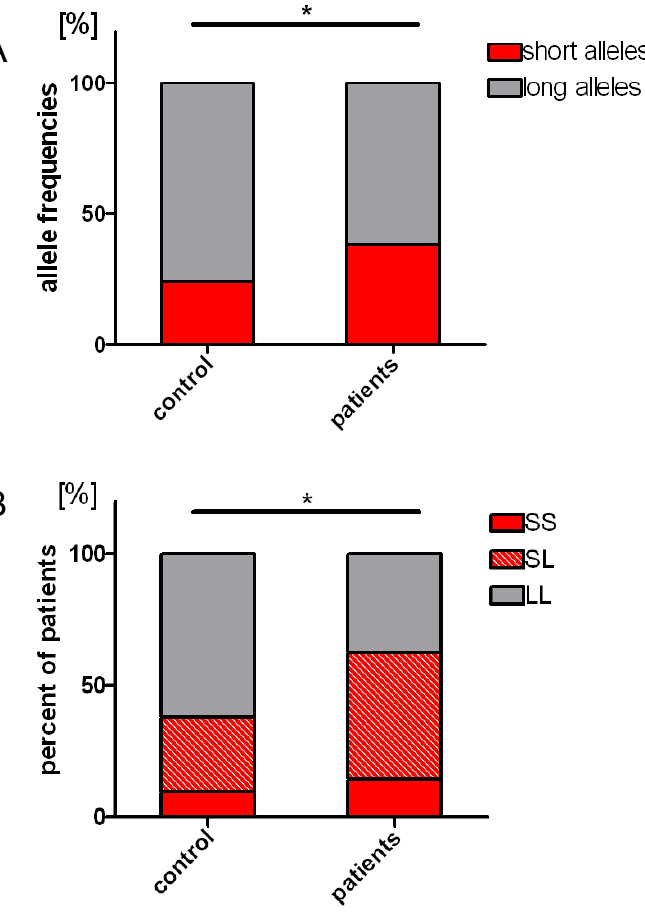
Figure 3. ( A ) Frequencies of short and long alleles in the patient and control groups. In ALL patients: 43 short alleles (38.4%) and 69 long alleles (61.6%); in control group: 20 short alleles (23.8%) and 64 long alleles (76.2%). ( B ) Comparison of percentage of patients and healthy controls with the SS, SL or LL genotype. In ALL patients: SS genotype—8 patients (14.3%), SL genotype—27 patients (48.2%), LL genotype—21 patients (37.5%). In controls group: SS genotype—4 individuals (9.5%), SL genotype—12 individuals (28.6%), LL genotype—26 individuals (61.9%). *— p < 0.05.